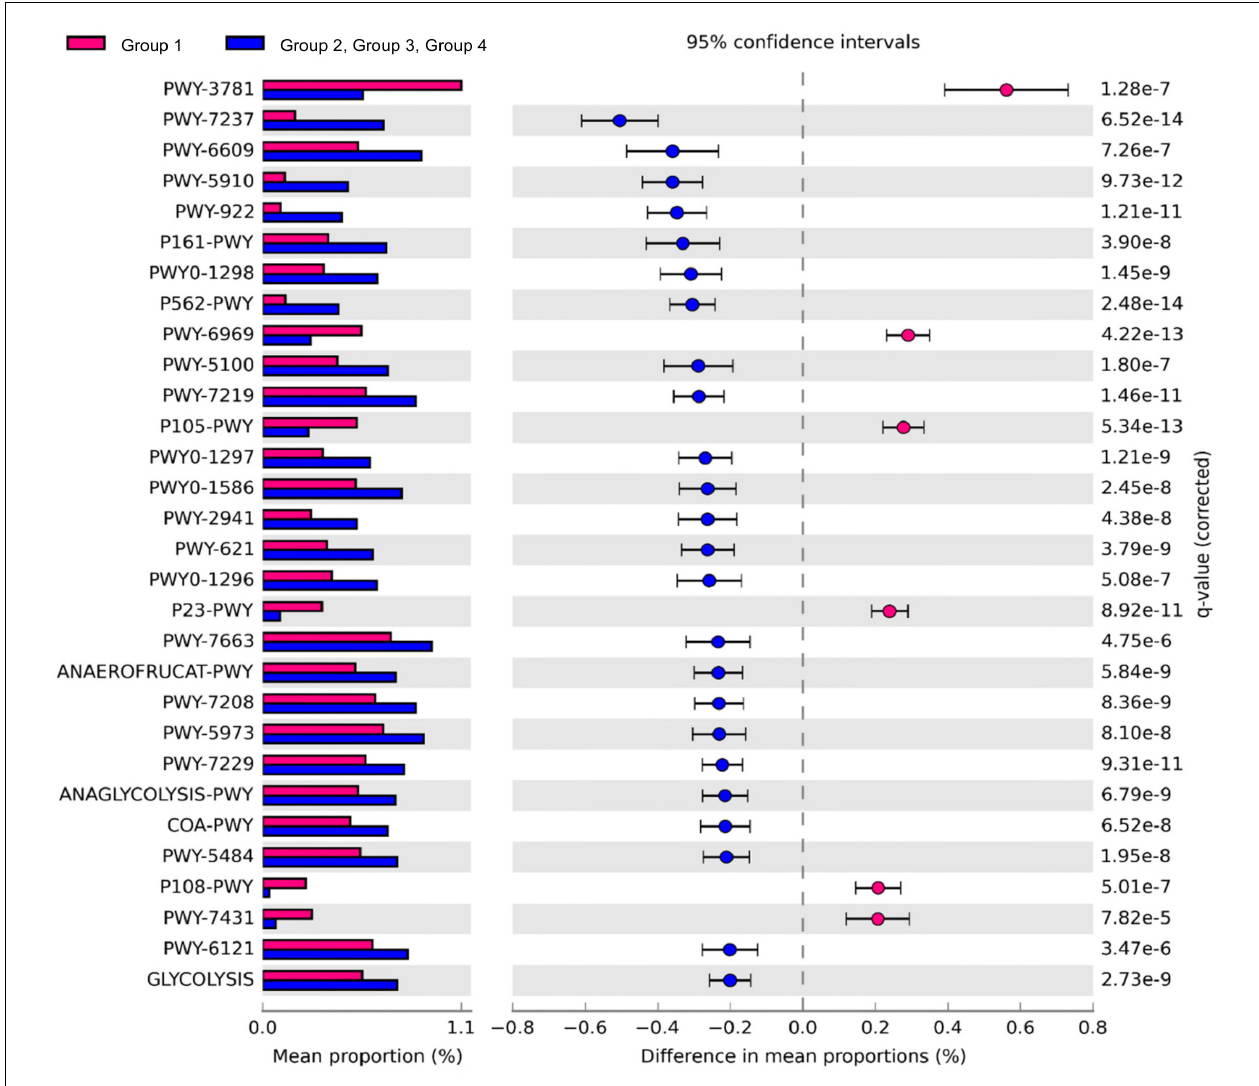
FIGURE 5 | Comparison of predicted pathways between group 1 and the other groups clustered in heat map analysis ( Figure 4 ). Pathways were predicted by PICRUSt2. The significantly different pathways between groups (Welch’s t -test q < 0.01) are shown.